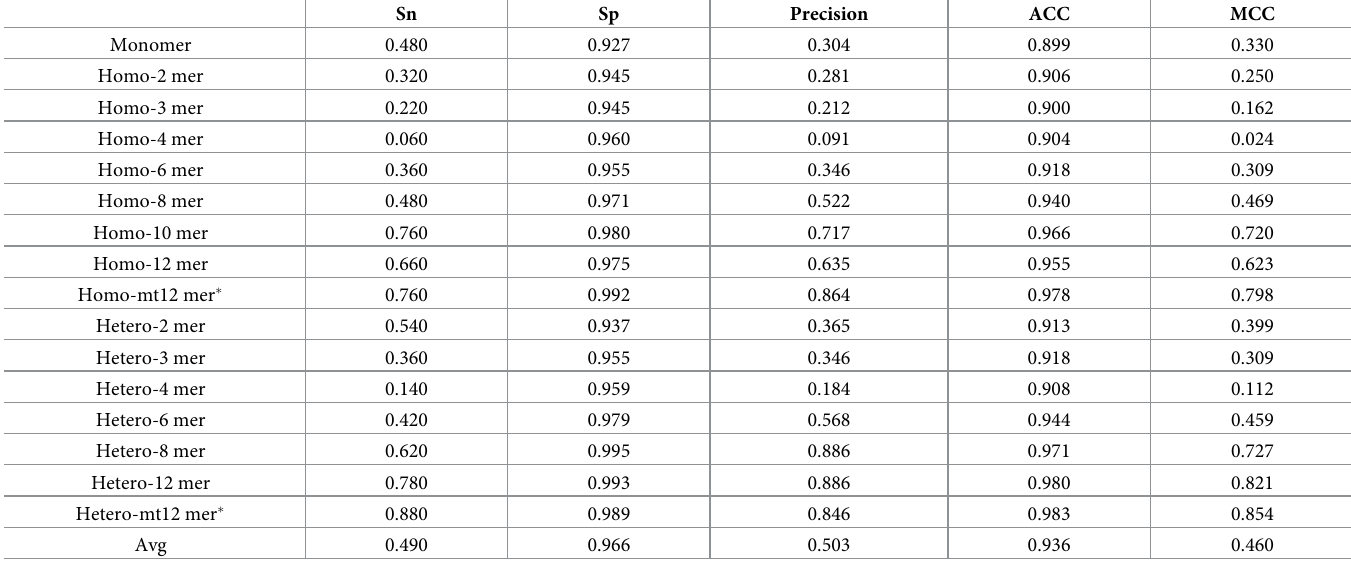
Table 4. Predicting results of the best classifier of the stage 1 classifier with cross verification. Sn Sp Precision